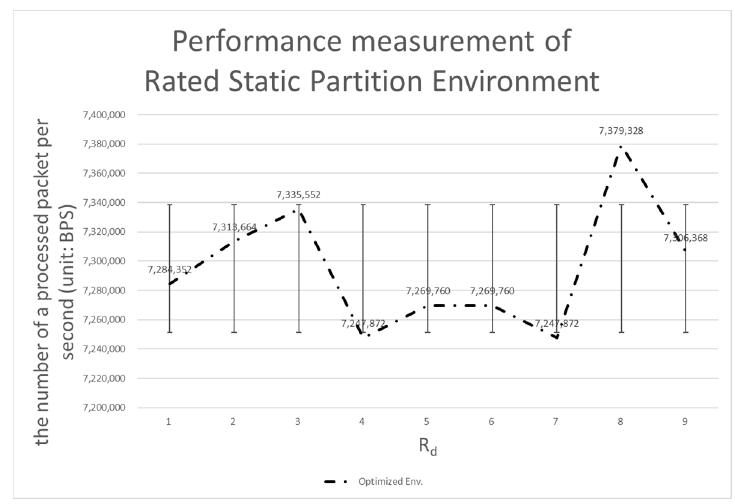
Figure 14. Performance measurement of the rated static partition environment.